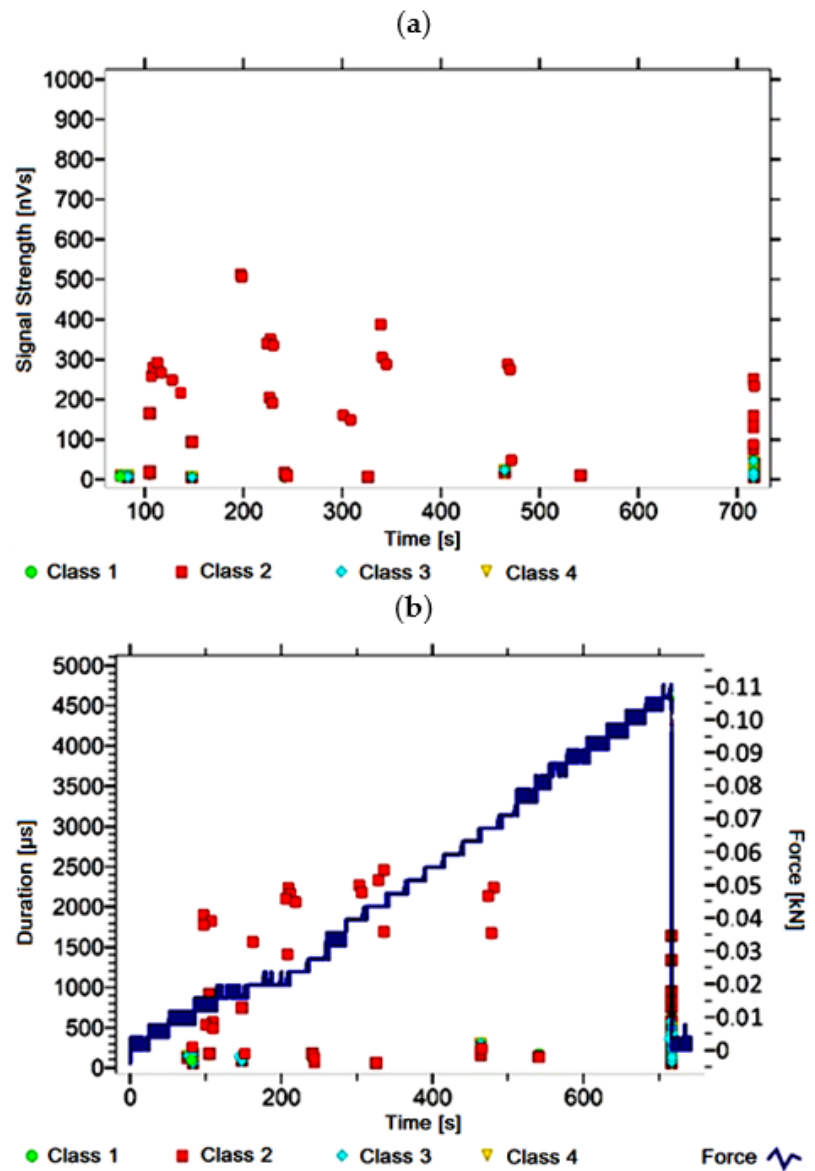
Figure 14. Graphs of acoustic emission signals for an exemplary sample of A 13 series: ( a ) signal strength over time; ( b ) distribution of the duration of the signals over time with the force increment curve.